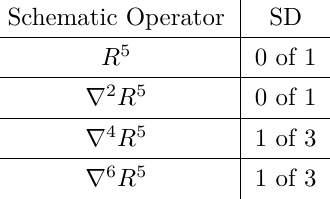
Table 5 . Number of tunable parameters in M 5 [1 + 2 + 3 + 4 + 5 + ] of the given form and number of tuneable parameters compatible with the double copy. Note that the generalized, string and cubic BAS double copy all generate the same set of higher dimension